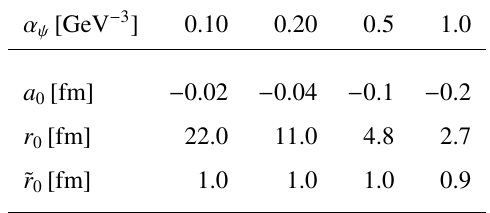
Table 1. ERE parameters for a spherical well with R N = 1 fm for di ff erent α ψ